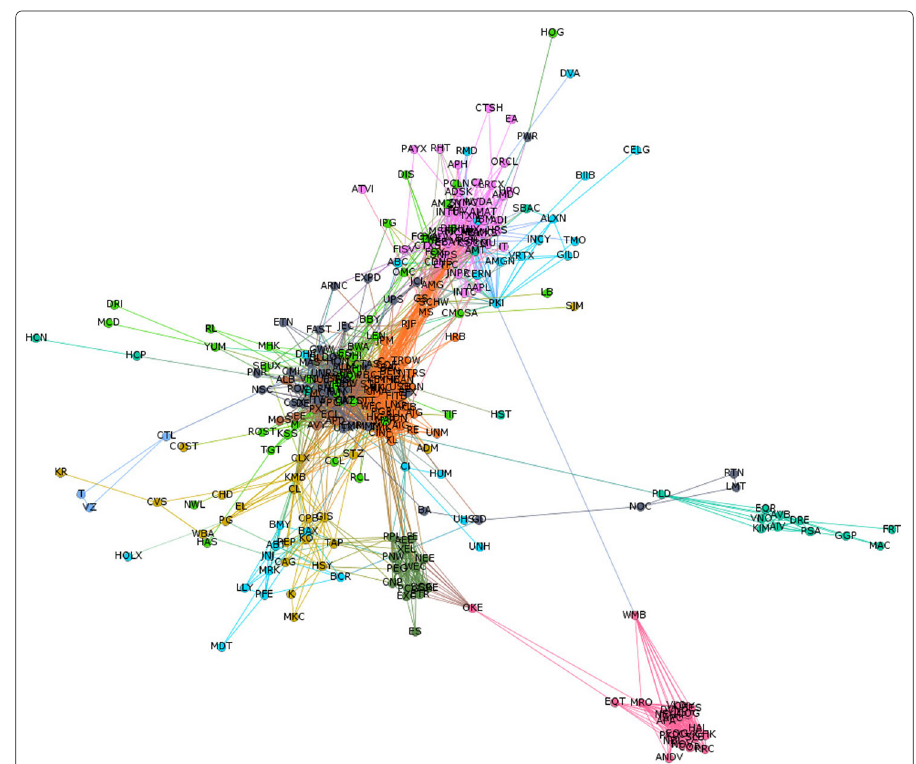
Fig. 1 Example correlation network inferred from the first window. Only the largest connected component of the network containing the 1000 edges with the largest absolute weights are shown. Nodes are coloured according to sector membership. There is a strong community structure visible, with communities usually made up of companies in the same